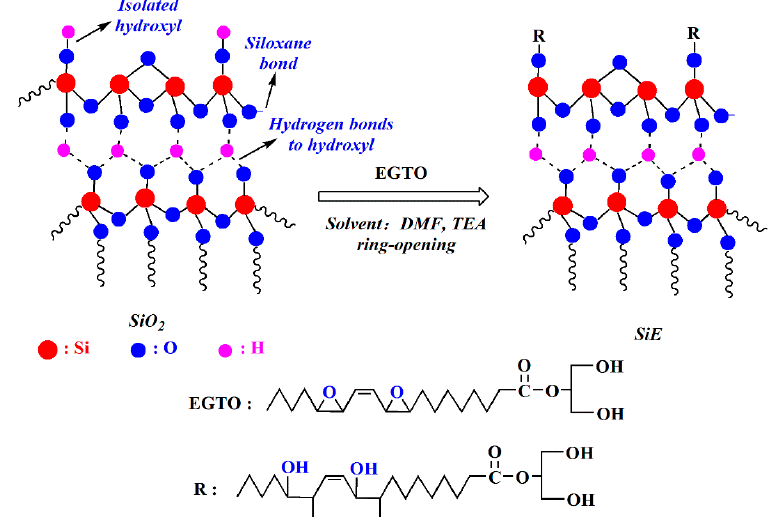
Figure 2. The synthesis route of grafted epoxidized monoglyceride of tung oil on the surface of SiO 2 (SiE). DMF— N , N -dimethylformamide; TEA—triethylamine; EGTO—epoxidized monoglyceride of tung oil.